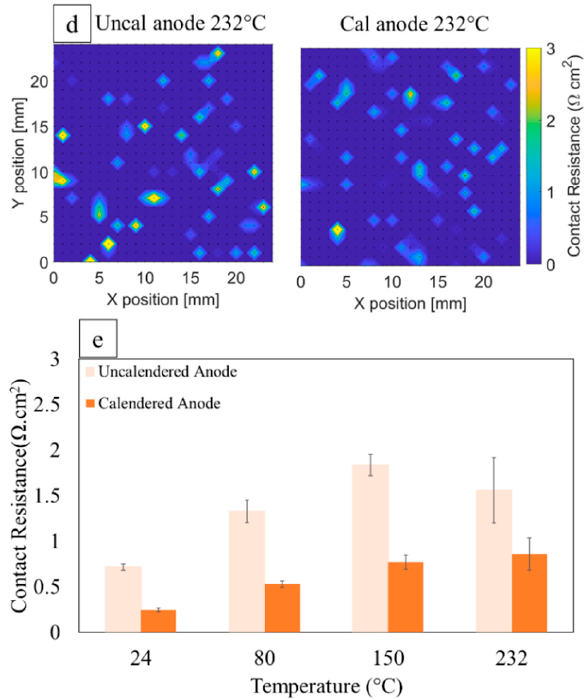
Figure 10. Contact-resistance maps of uncalendered and calendered anodes dried at ( a ) 24 °C, ( b ) 80 °C, ( c ) 150 °C, and ( d ) 232 °C, and ( e ) comparison between the average contact resistances of ( b ) 80 ◦ C, ( c ) 150 ◦ C, and ( d ) 232 ◦ C, and ( e ) comparison between the average contact resistances of anodes before and after calendering. anodes before and after calendering.